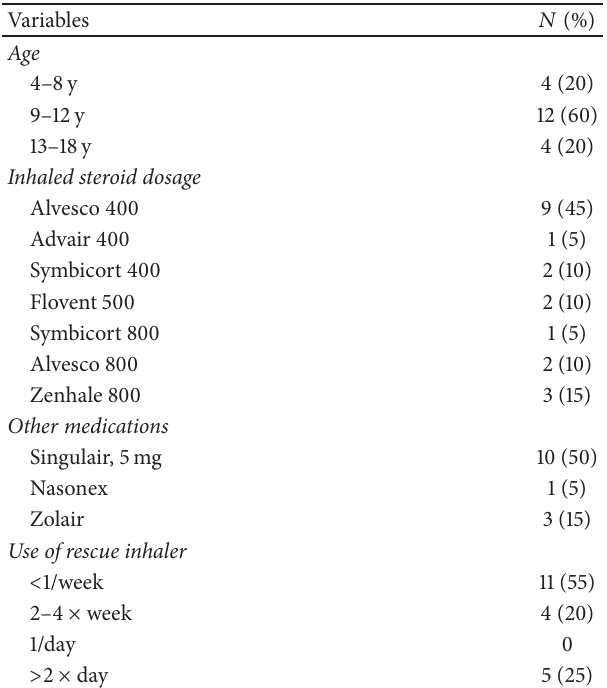
Table 1: Patient